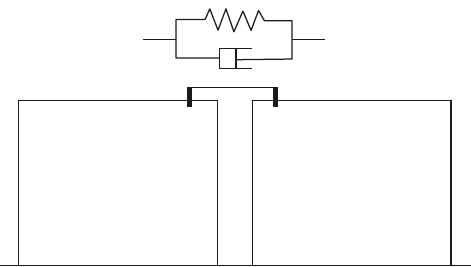
Figure 1: Simplified model of adjacent structures connected with joint